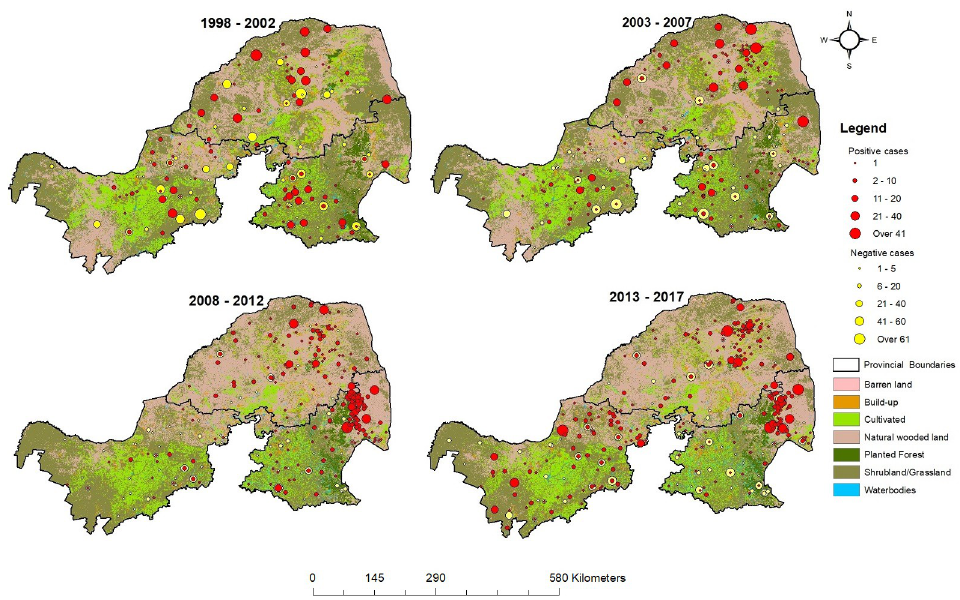
Fig 2. Spatial distributions of positively and negatively diagnosed animals between 1998 and 2017, and changes in land use over time. < https://www.dffe.gov.za > . https://doi.org/10.1371/journal.pntd.0010464.g002 Mpumalanga Provinces (Fig 2). Changes in vegetation were the most apparent, with the replacement of grassland with naturally wooded land, particularly in Limpopo Province. Among all positive animal rabies cases, domestic animals accounted for 78.5% (2,045/ 2,605) and wildlife 21.5% (560/2,605) (Table 1). The overall positivity rates were 33.8% in Table 1. Number of animal specimens submitted to the laboratory and confirmed as positive, and positivity rates for domestic and wildlife species.